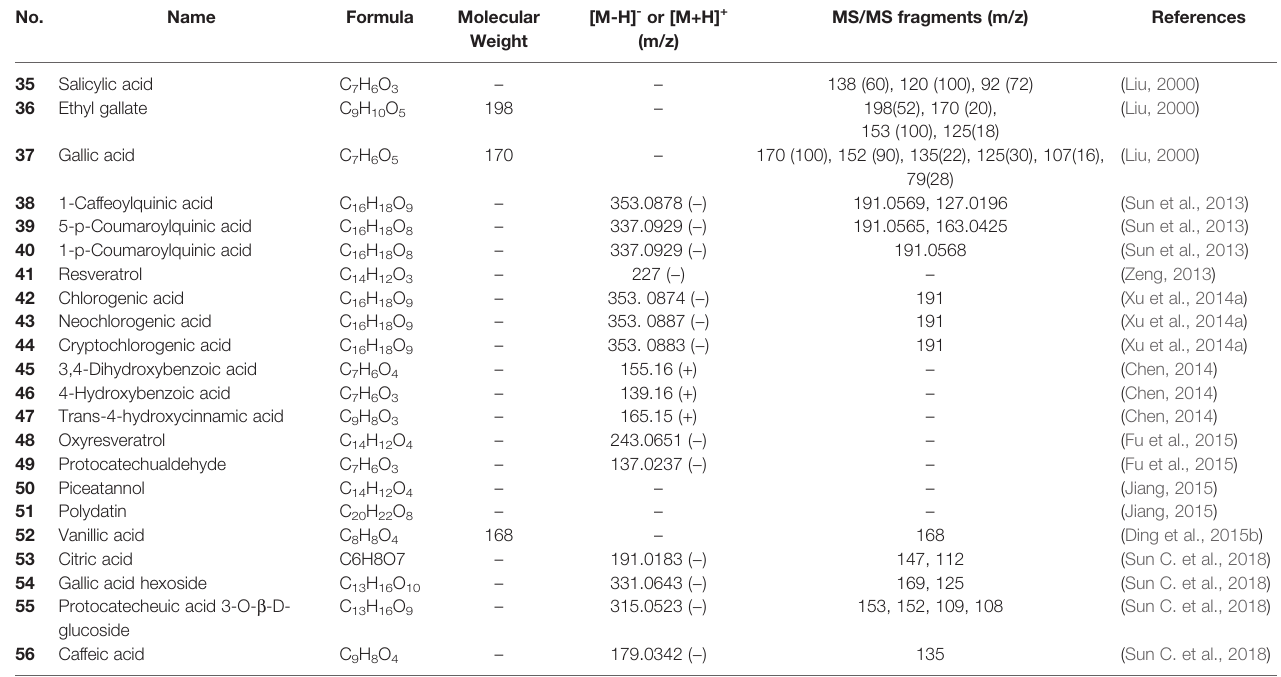
TABLE 2 | Phenolic acids isolated from Tetrastigma hemsleyanum Diels &